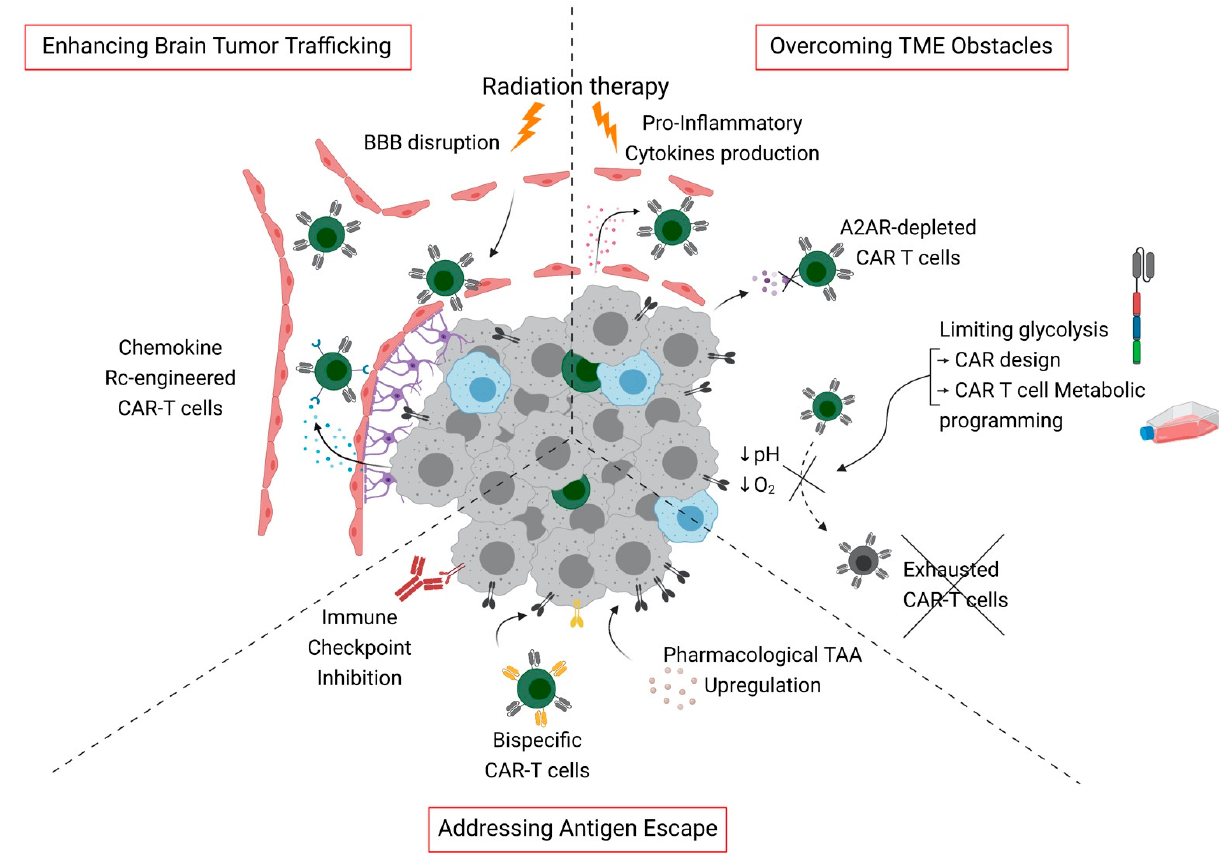
Figure 1. Strategies for improving the efficacy of CAR T cell therapy in pediatric brain tumors. Top left: CAR T cell trafficking into the tumor site depends on the expression of receptors for chemokines secreted by the tumor. CAR T cells endogenously express chemokine receptors, but their respective ligands are not expressed by tumor cells. CAR T cells can be engineered to express receptors (e.g., CCR4) for chemokines secreted by tumor cells to improve CAR T cell homing to tumors. Alternatively, CAR T cell infusion can be combined with radiation therapy, which induces the release of proinflammatory cytokines to increase CAR T cell recruitment into the tumor. Bottom: Tumor cells escape CAR T cell killing by downregulating CAR target expression. CAR target expression can be induced using epigenetic molecules. Bi- or multispecific CAR T cells can be used to avoid the emergence of antigen-negative tumor clones. Antigen-activated CAR T cells in the TME upregulate immune checkpoint molecules that induce T cell dysfunction and tumor escape. ICM inhibitors can be used as adjunct therapy, or CAR T cells can be genetically modified to avoid the expression of ICM receptors and T cell dysfunction. Top right: The hypoxic tumor microenvironment is rich in soluble factors such as immunosuppressive cytokines and tumor metabolites that can inhibit CAR T cells directly or indirectly. A2AR genetic depletion in CAR T cells increases T cell resistance to adenosine. Glutaminolysis inhibitors, CAR design, and/or T cell engineering impact CAR T cell fitness and antitumor efficiency. CAR T cells can be further engineered to express activating receptors specific for immunosuppressing cytokines present in the TME. Lastly, adjunct radiotherapy can be used to tame the immunosuppressive TME and increase CAR T cell antitumor activity.